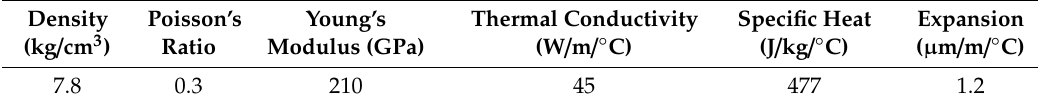
Table 4. Physical properties of the AISI52100.